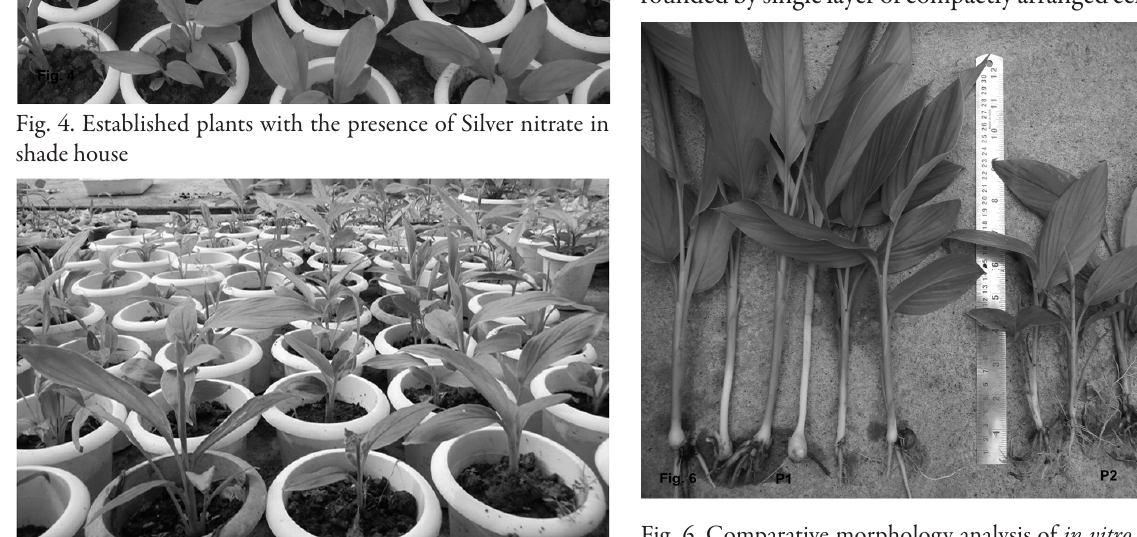
Fig. 6. Comparative morphology analysis of in vitro developed plantlets with and without AgNO